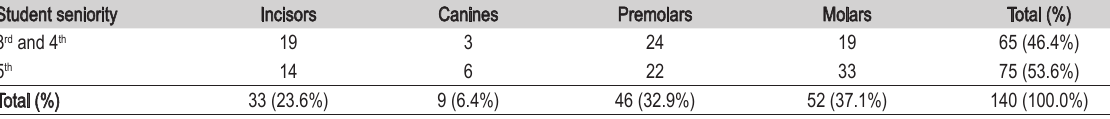
Table 2 - Distribution of teeth in the sample.